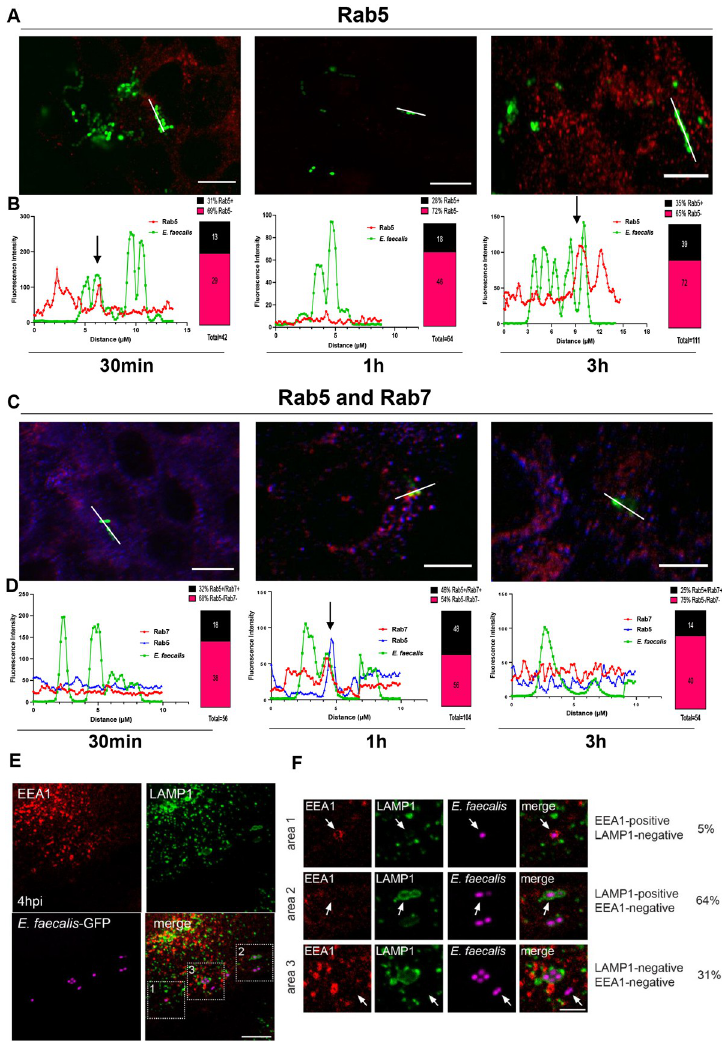
Fig 4. Intracellular E . faecalis displays heterotypic trafficking through early and late endosomes in keratinocytes. (A) CLSM of infected keratinocytes labelled with antibodies against Rab5 (Alexa fluor 568, red, early endosome) at 30 min, 1 hpi and 3 hpi. (B) Representative fluorescence intensity profiles of immunolabeled Rab5 and fluorescent E . faecalis (pDasherGFP, green) was assessed over a linear segment of E . faecalis cells (derived from the white lines shown in panel A). Labeling of individual cells was manually scored using a combination of histogram overlap (where each cell is a peak on the histogram) and visualization of orthogonal views and 3D projections generated using Imaris 9.0.2. Arrows indicate points of colocalization. Images are representative of three independent experiments. Percentage of E . faecalis associated with Rab5 was derived from a minimum of 8 individual confocal images per time point (2–3 images per biological replicate). (C) CLSM of infected keratinocytes labelled with antibodies against Rab5 (Alexa Fluor 568, blue; early endosome) and Rab7 (Alexa Fluor 647, red; late endosome) at 30 min, 1 hpi and 3 hpi. (D) Representative fluorescence intensity profiles of immunolabeled Rab5 immunolabeled Rab7 and E . faecalis (pDasherGFP, green) was assessed over a linear segment (derived from the white lines shown in panel C) and scored as described for panel B. Arrow indicates points of colocalization. Images are representative of three independent experiments. Percentages are derived from a minimum of 8 individual confocal images per time point. CLSM of infected HaCaTs immunolabeled for EEA1 (early endosome) and LAMP1 (late endosome/lysosome) at 4 hpi. (F) Magnified images of boxed areas in (A) showing representative images of E . faecalis containing compartments. Percentages are derived from 10 individual confocal images and a total of 55 E . faecalis diplococci. Images are maximum intensity projections of 4–5 optical sections (~2 μ m z-volume) and are representative of 3 independent experiments. Scale bars: A: 10 μ m; C: 10 μ m; E: 10 μ m; F: 2 μ m. (See S7 and S8 Figs for additional representative images).